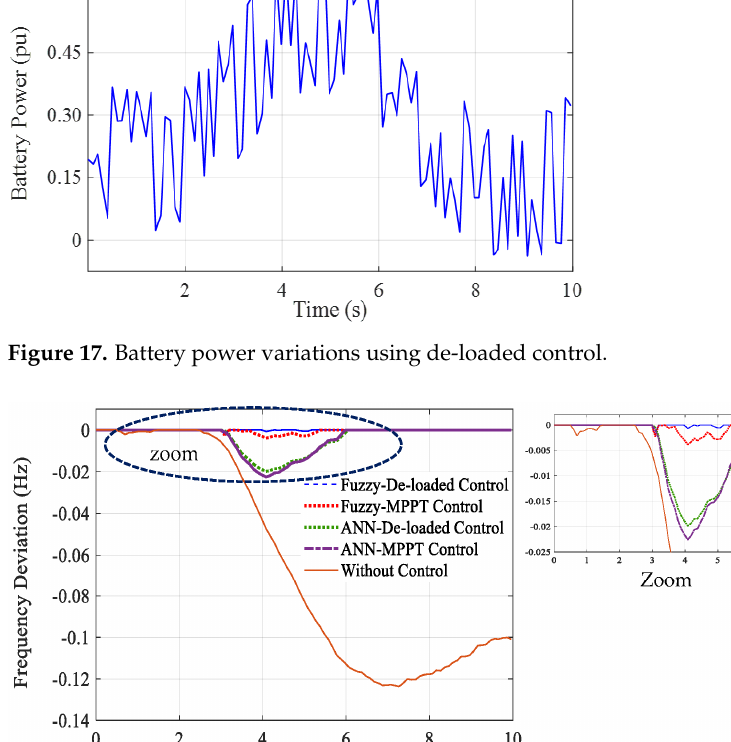
Figure 18. DT-FLC and MPPT frequency control variation. 7. Conclusions In this paper, a new control strategy is investigated for connected-MG and islanded- MG based on the DT-FLC. The studied MG is more resilient during and after a fault due to the ARS control by absorbing kinetic energy from the rotor. The findings show that an MG using the suggested approach is much better at responding to the LVRT requirement (connected mode) and PFR (islanded mode) when compared to the MPPT and ANN con- trol. Furthermore, the BESS operation is explored to enhance the suggested control. When faults occur, BESS support is employed to preserve stability and mitigate the negative effects of grid integration. In addition, the PWM-based-FLC is suggested to govern the PMSG-side converter. Finally, from the obtained results in both cases, the proposed tech- nique has shown the system stability and robustness and has successfully maintained the